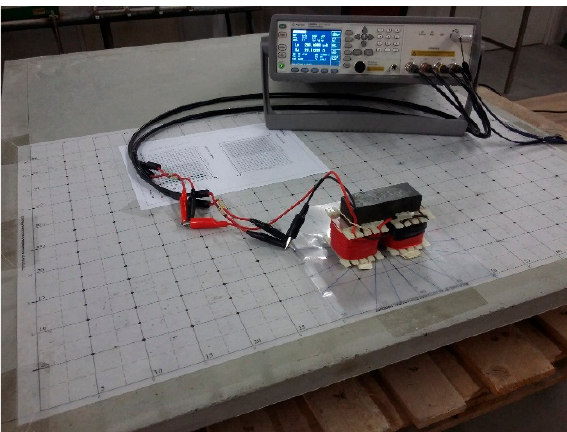
Figure 1. Measurements performed on a UHPFRC large plate using the magnetic probe and an LCR meter. Table 1. Characteristics of the magnetic probe.